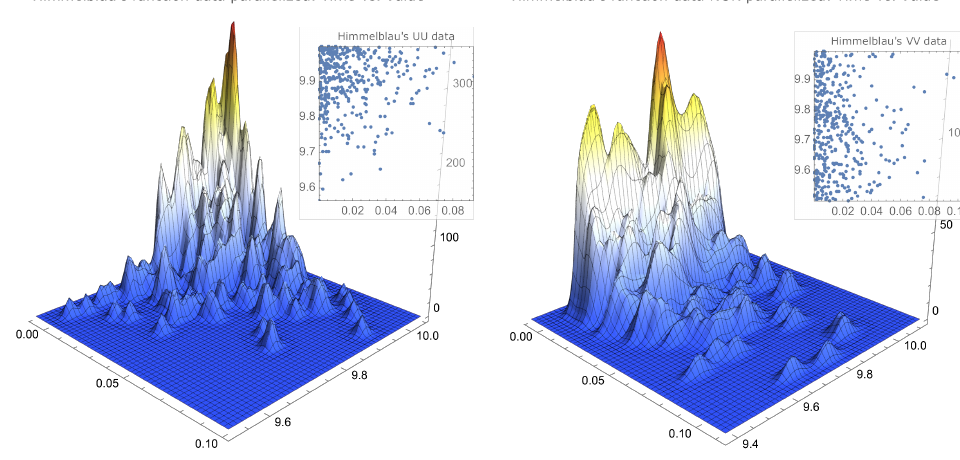
Figure 2. Smoothed histograms and simulation data for Himmelblau’s